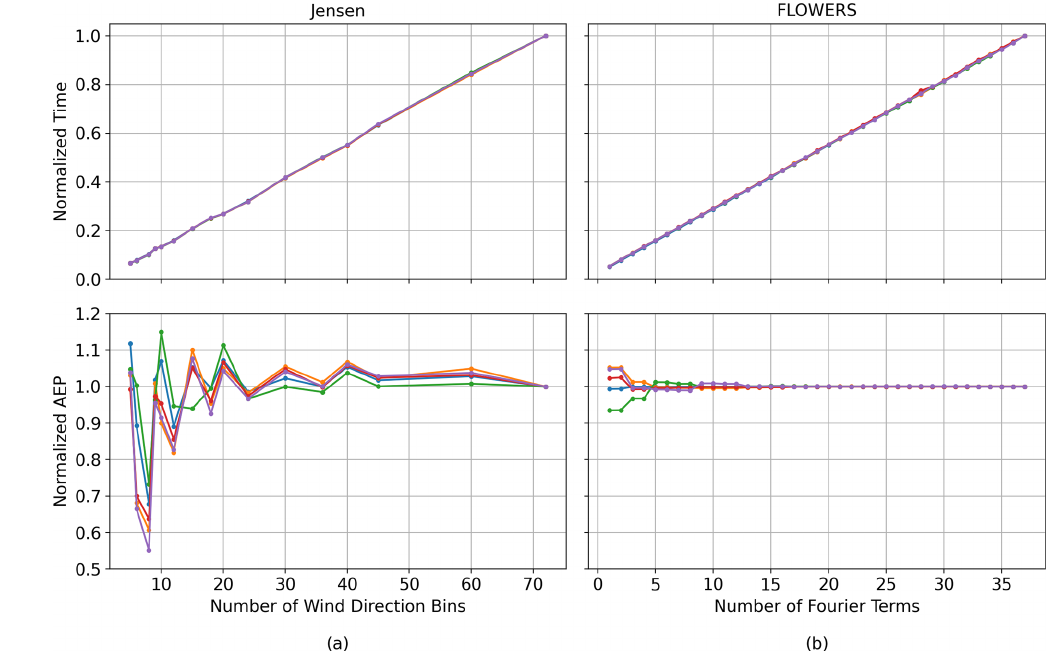
Figure 7. The effect of the resolution of wind direction bins in the Jensen model (a) and number of Fourier modes in FLOWERS (b) on cost (top panels) and accuracy (bottom panels) of the AEP calculations. Each colored line represents one of five sampled wind roses. AEP is computed for a seven-by-three grid of turbines with a spacing of 5 D . Values are normalized in each plot by the highest-resolution data point. For context, computation times are on the order of